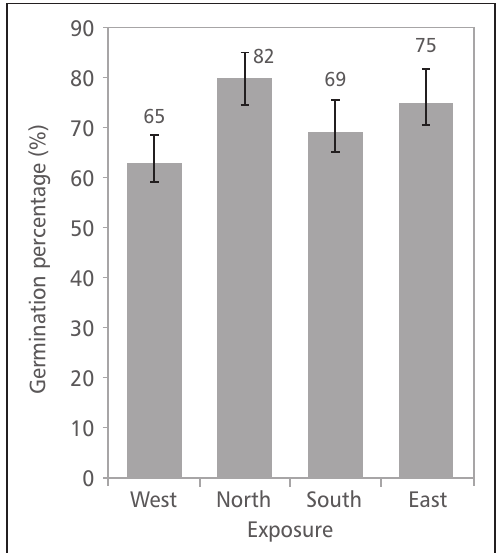
FIGURE 4. The effects of exposure factor on germination percentage While the effects of elevation and the tree age factors on 100 seed weight had no significance, the effect of the exposure factor had showed significant noteworthy